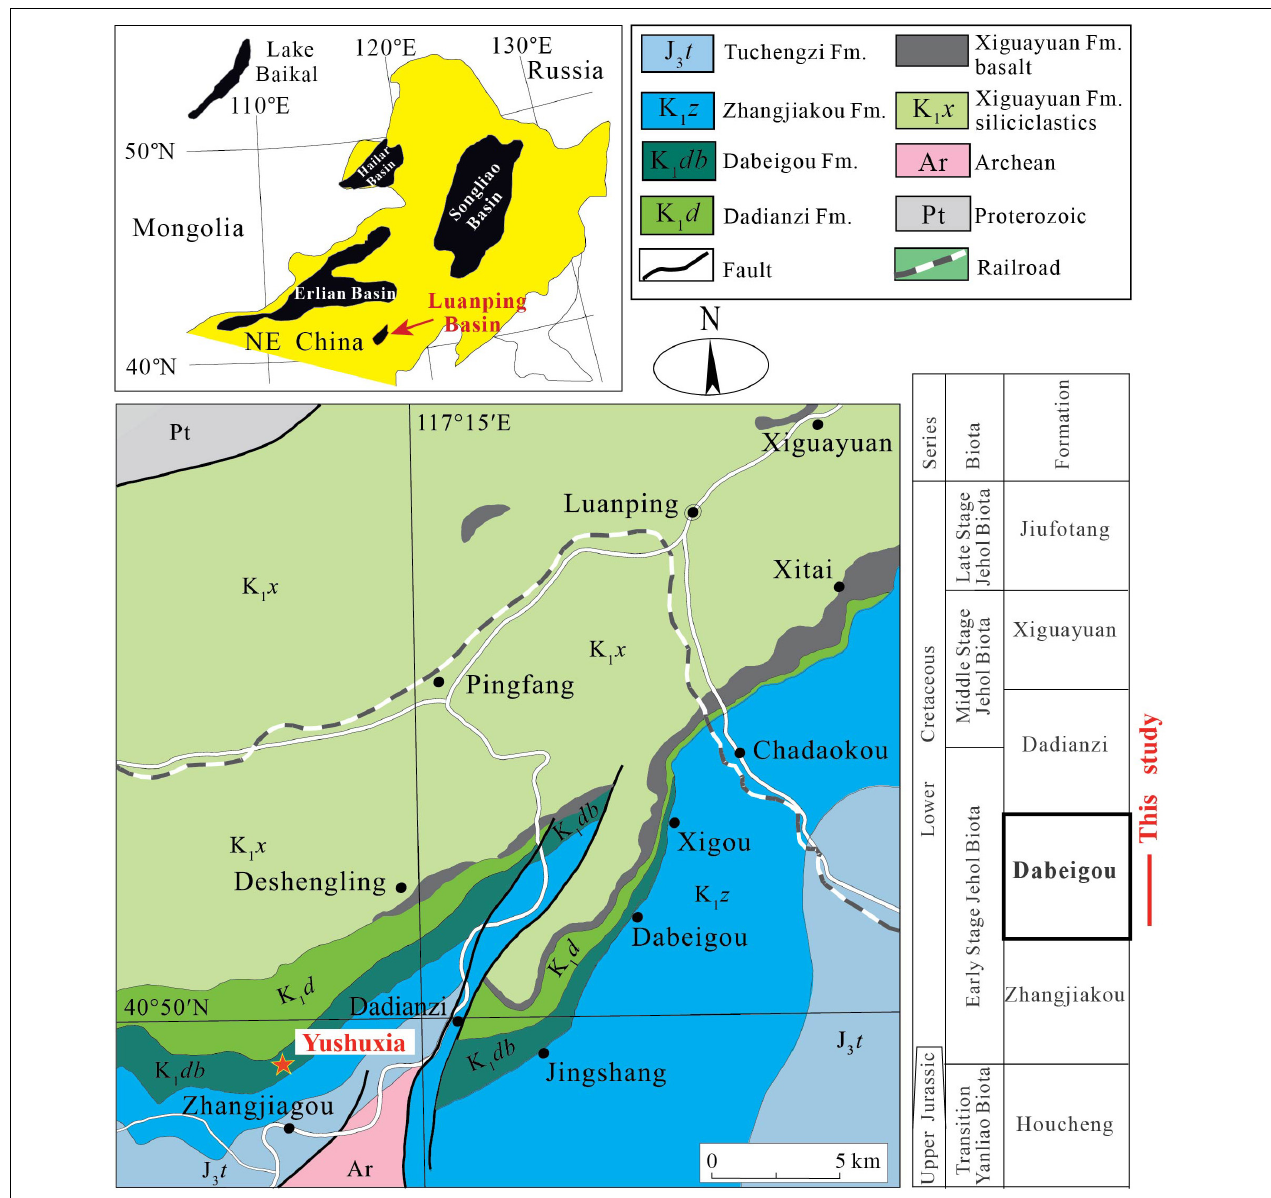
FIGURE 1 | Left: Map of northeastern China, Songliao Basin (SLB), and Luanping Basin (LPB), modified from Qin et al. (2018). The location of the Yushuxia section is indicated with the red star, at GPS coordinates 40 ◦ 47 (cid:48) N, 117 ◦ 12 (cid:48) E. Right: Lower Cretaceous stratigraphic column of northern China indicating the evolution stages of the Jehol Biota. The Dabeigou Formation is highlighted with bold lines; the stratigraphic coverage of this study is shown by the vertical red line at the far right.